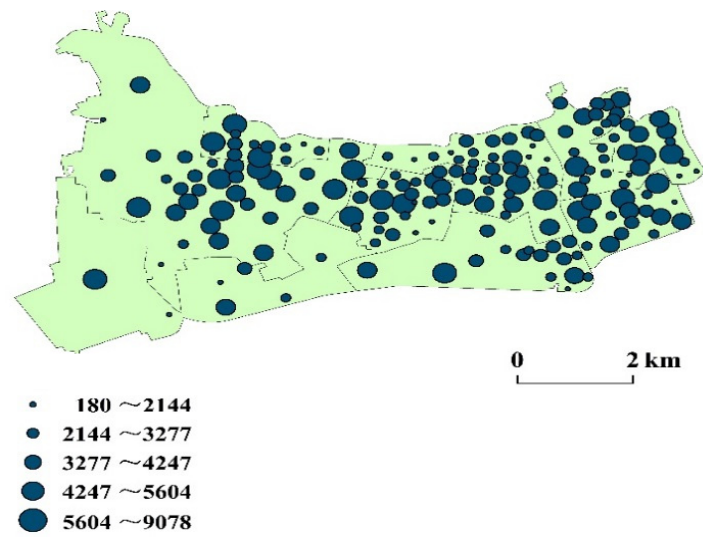
Figure 4. Distribution of residential areas in Changning District.